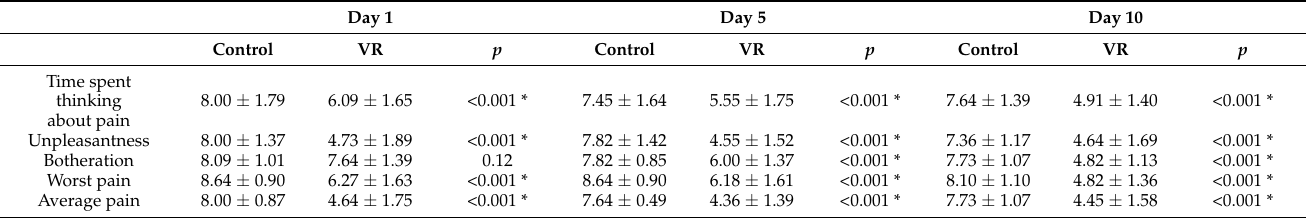
Table 2. Comparison of the mean pain scores between RAGT with VR and RAGT without VR.